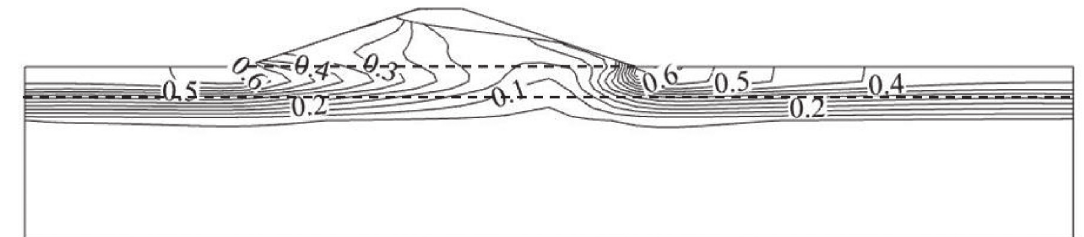
Figure 4: Mean of the hydraulic gradient contour through the embankment.